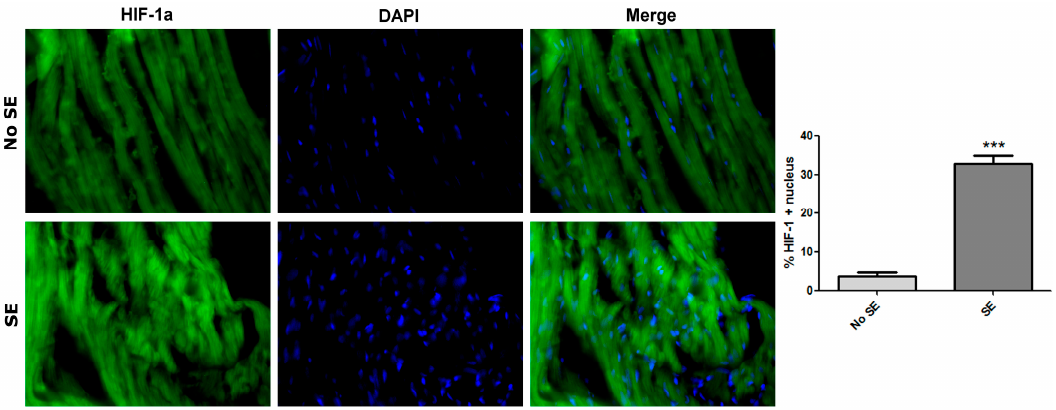
Figure 3. Cardiac hypoxia-inducible transcription factor (HIF)-1 α expression. Micrographs (20 × ) of the myocardium expressing HIF-1 α after SE and their quantification. Bars are the mean ± SEM. Differences were analyzed by Student t -test with a significance level of p < 0.001 (***).